Question: In a single sentence, describe what this figure presents.
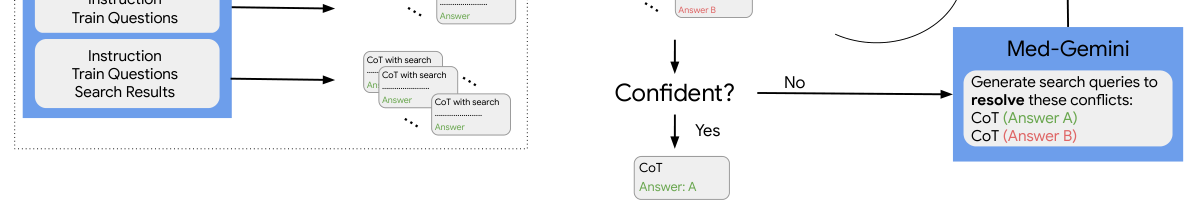
Answer: | Self-training and search tool-use. The left panel illustrates the self-training with search framework used to fine-tune Med-Gemini-L 1.0 for advanced medical reasoning and use of web search. This framework iteratively generates reasoning responses (CoTs) with and without web search, improving the model’s ability to utilize external information for accurate answers. The right panel illustrates Med-Gemini-L 1.0’s uncertainty-guided search process at inference time. This iterative process involves generating multiple reasoning paths, filtering based on uncertainty, generating search queries to resolve ambiguity, and incorporating retrieved search results for more accurate responses.